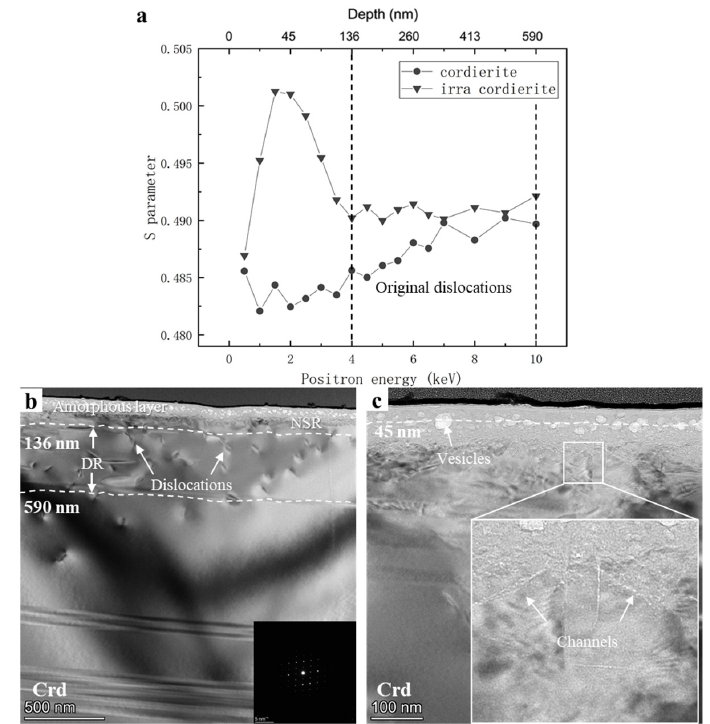
Figure 5. ( a ) S – E curves of cordierite and irradiated cordierite. The black dashed line represents the original dislocation region. ( b ) TEM bright-field and ( c ) HRTEM images of plagioclase. The SAED pattern of cordierite is shown in the insert in the bottom right corner of ( b ). The white dashed lines represent the current depth. NSR, near-surface region; DR, deeper region.